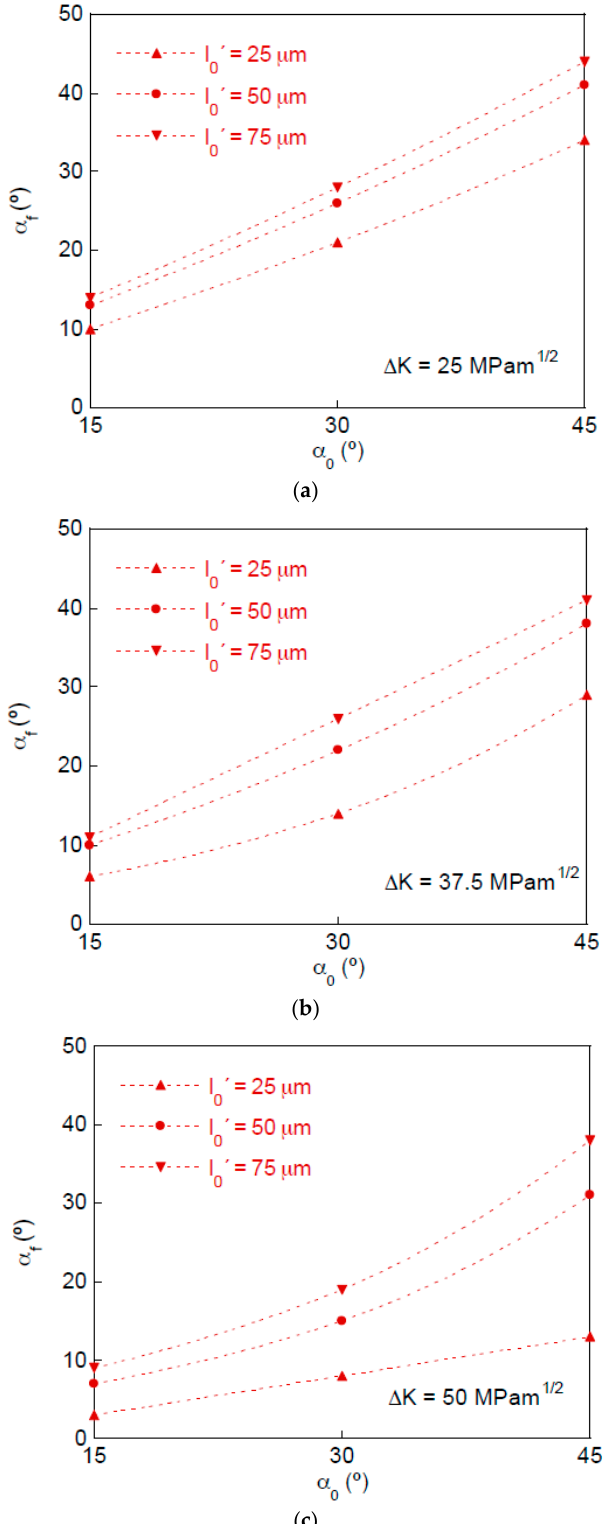
Figure 9. Final angle of the kinked crack tip after 20 cycles: ( a ) Δ K = 25 MPam 1/2 ; ( b ) Δ K = 37.5 MPam 1/2 ; and ( c ) Δ K = 50 MPam 1/2 .